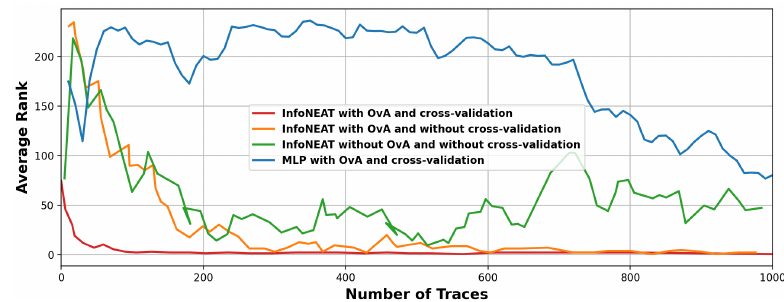
Figure 7: Comparison of average rank obtained for different models obtained with and without stacking and cross-validation. For this experiment, ASCAD fixed sync dataset is